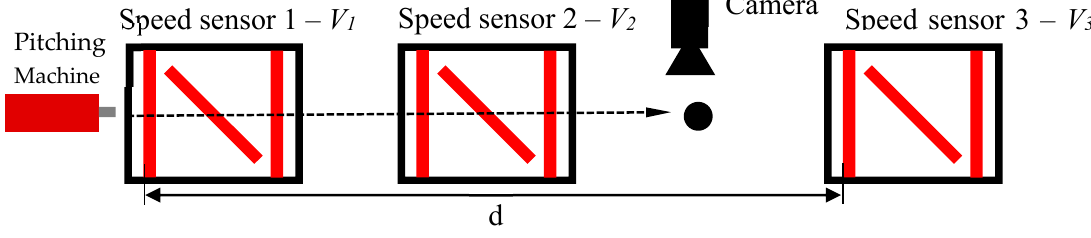
Figure 3. Arrangement of the pitching machine, speed sensors and camera to measure ball speed, rotation and location. The gate aligned vertically measured ball speed, while the angled gates measured position.